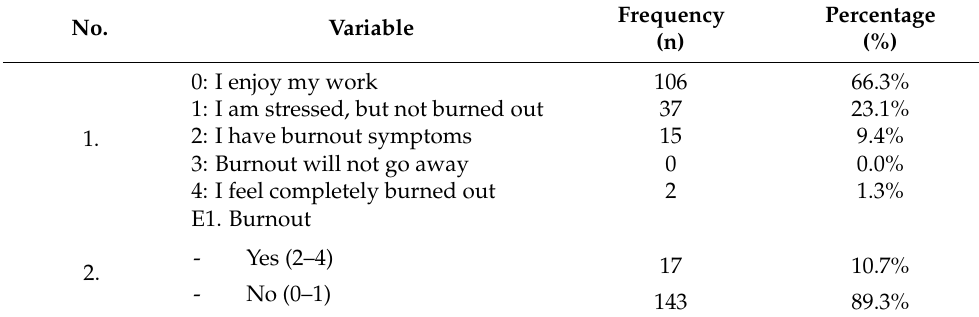
Table 1. Prevalence of burnout.